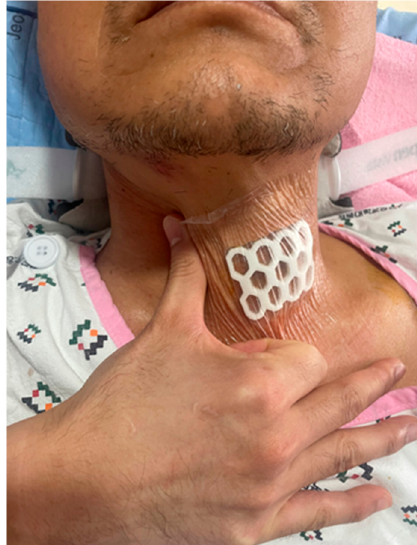
Figure 2. Laryngeal rehabilitation therapy: laryngeal manipulation. A physician pushes the patient’s laryngeal area including thyroid cartilage from the right to the left side. Voluntary swallowing is allowed by patients ten times at each cycle.